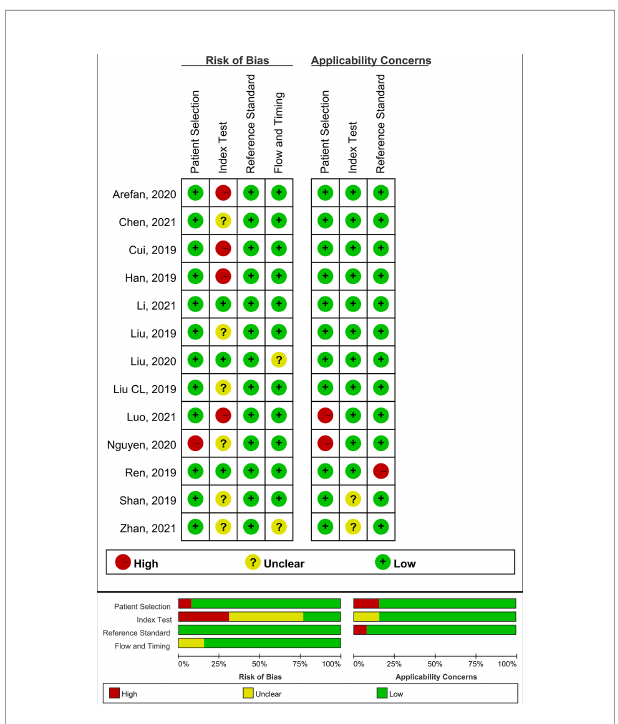
FIGURE 2 | The risk of bias (left) and concerns for applicability (right) for each included study using